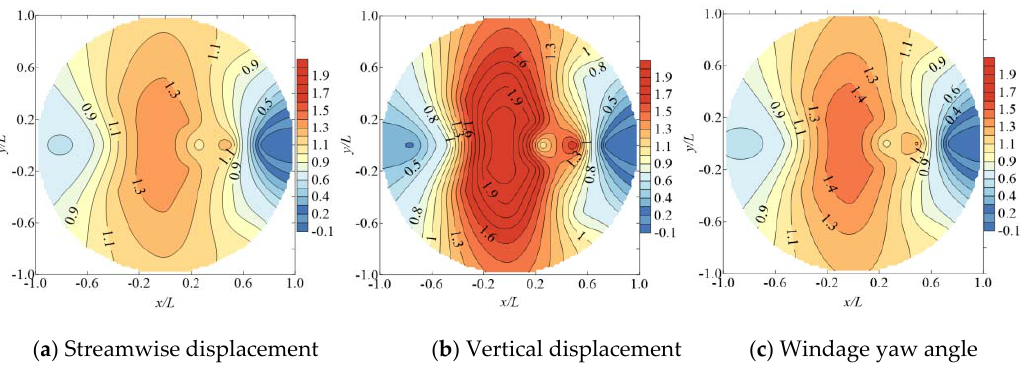
Figure 19. Normalized wind ‐ induced responses of the jumper cable (only streamwise wind speed is